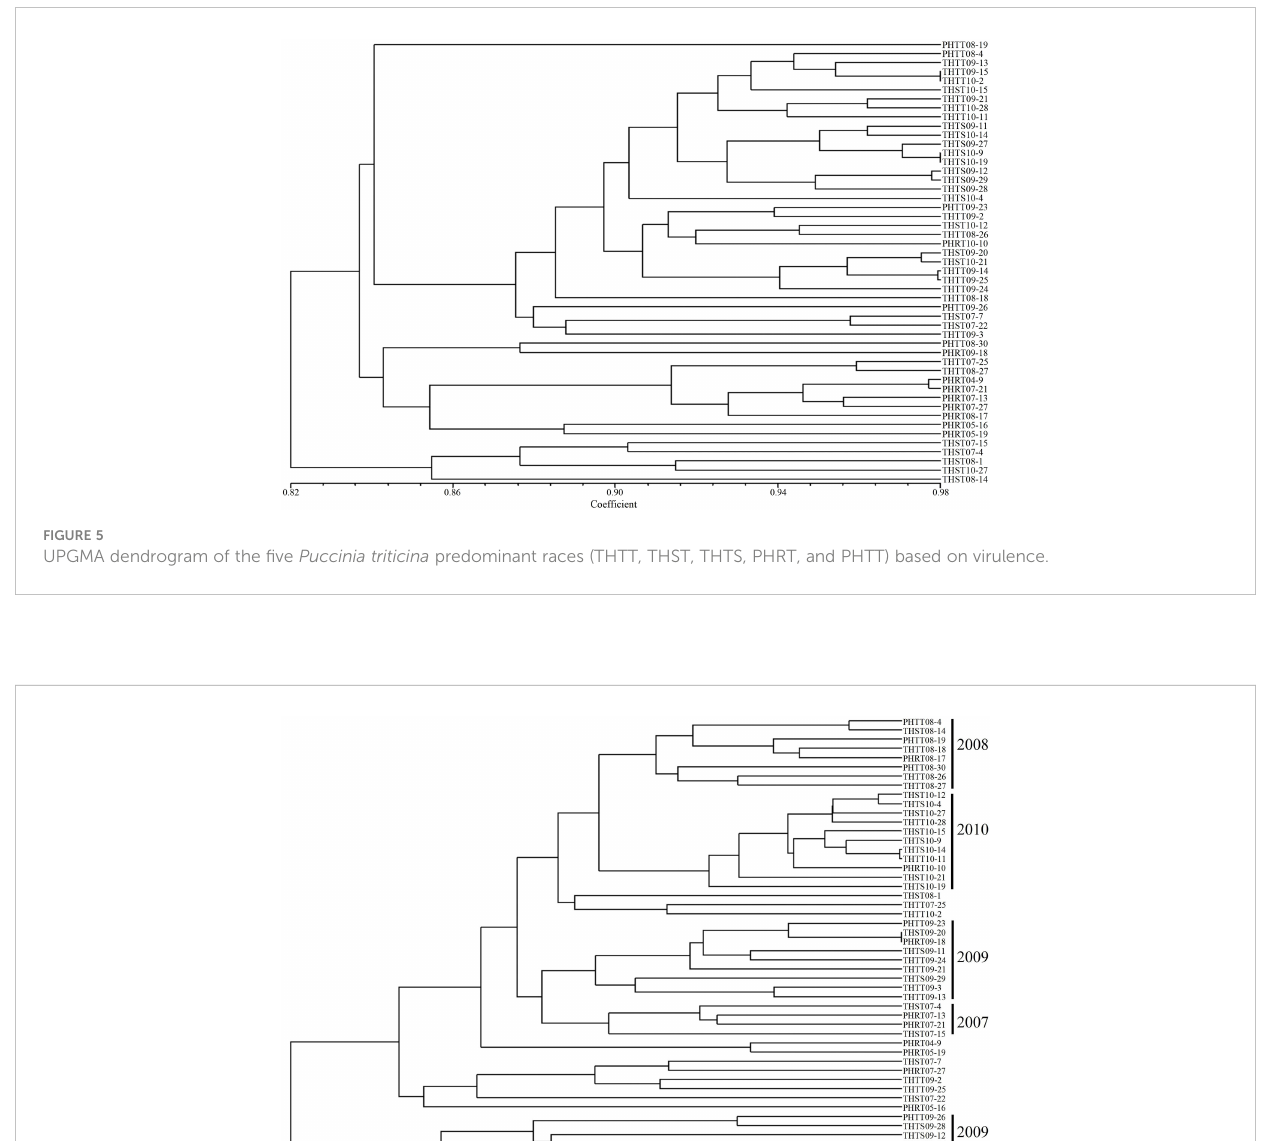
FIGURE 6 UPGMA dendrogram of the fi ve Puccinia triticina predominant races (THTT, THST, THTS, PHRT, and PHTT) based on EST -